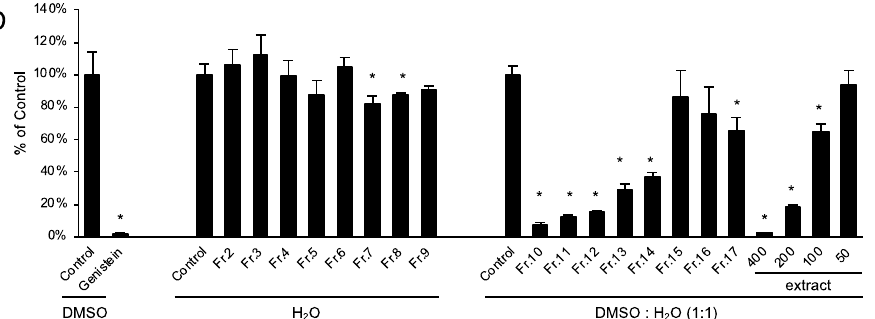
Figure 5. Inhibitory effects against growth of ATL cell lines and antioxidant activity of fractions from water extracts of V. virgatum stems. ( A ) S1T cell, ( B ) ED cell, ( C ) MT-2 cell, ( D ) Jurkat cell. S1T and ED were ATL cell lines, MT-2 was HTLV-1–infected cell line and Jurkat HTLV-1–negative human T-cell acute lymphoblastic leukemia cell line. Concentration of all fractions and genistein were 50 μ g/mL. Concentrations of blueberry stem extract were 400, 200, 100, and 50 μ g/mL. Data are mean ± SD for three independent experiments. Significantly different from each control value: p < 0.05 (*) (Student’s t -test). The amounts of fractions 1, 18, and 19 were insufficient for the experiment. Considering the polarity of each fraction, fractions 2–9 were dissolved in H 2 O, and fractions 10–17 and extracts were dissolved in DMSO:H 2 O (1:1). Genistein was used as a positive control and dissolved in DMSO. These solutions were then diluted with medium to a final concentration of 0.1% for the first solvent (H 2 O or DMSO:H 2 O (1:1) or DMSO) used.